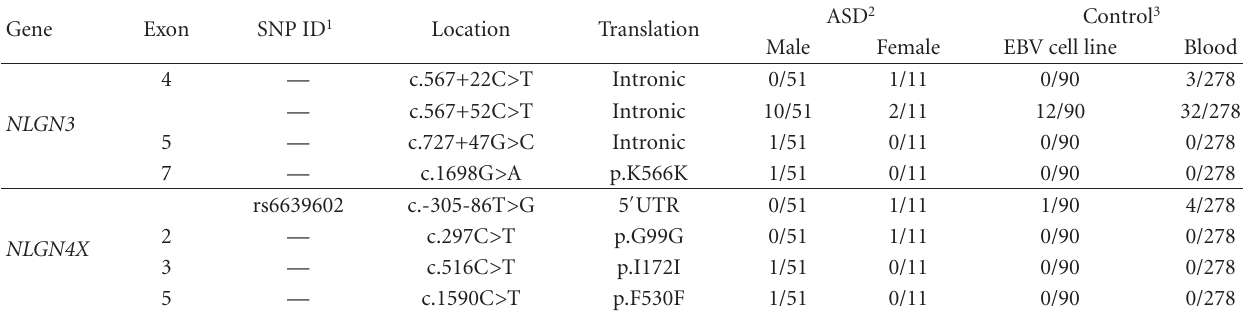
Table 3: Sequence variants identified in Japanese patients with autistic spectrum disorder.